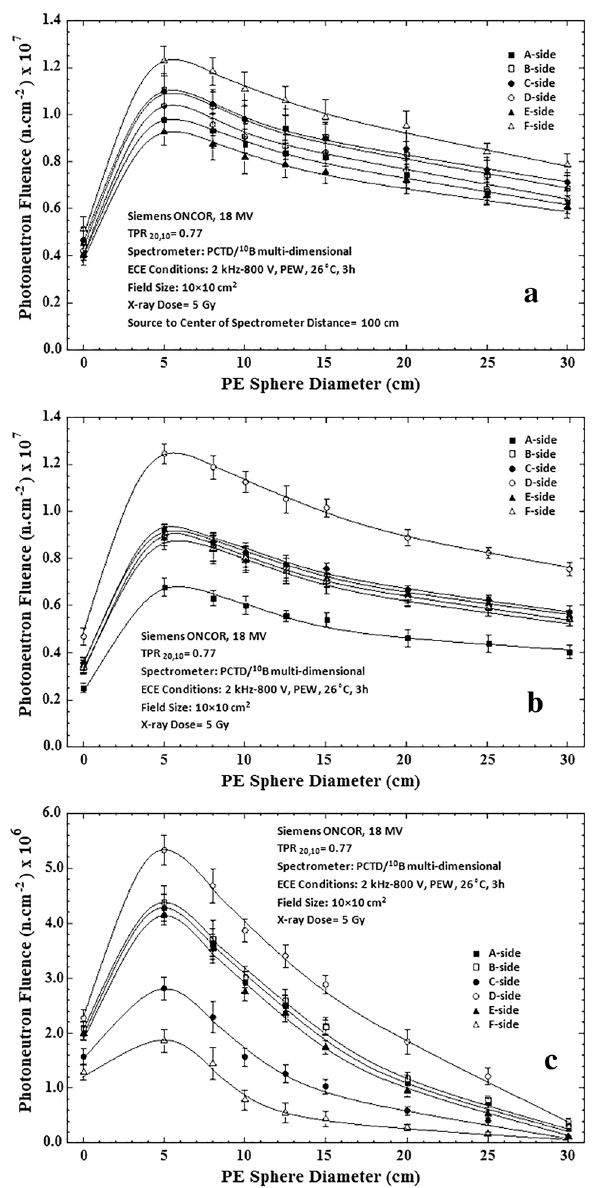
Figure 4. Photoneutron fluence versus diameter of the PE spheres for all six side PCTD/ 10 B detectors as determined at 3 spectrometry locations in the radiotherapy bunker; ( a ) isocenter, ( b ) 50 cm from isocenter, and ( c ) maze-room junction for 5 Gy dose of 18 MV X-rays in a 10 × 10 cm 2 field of the medical